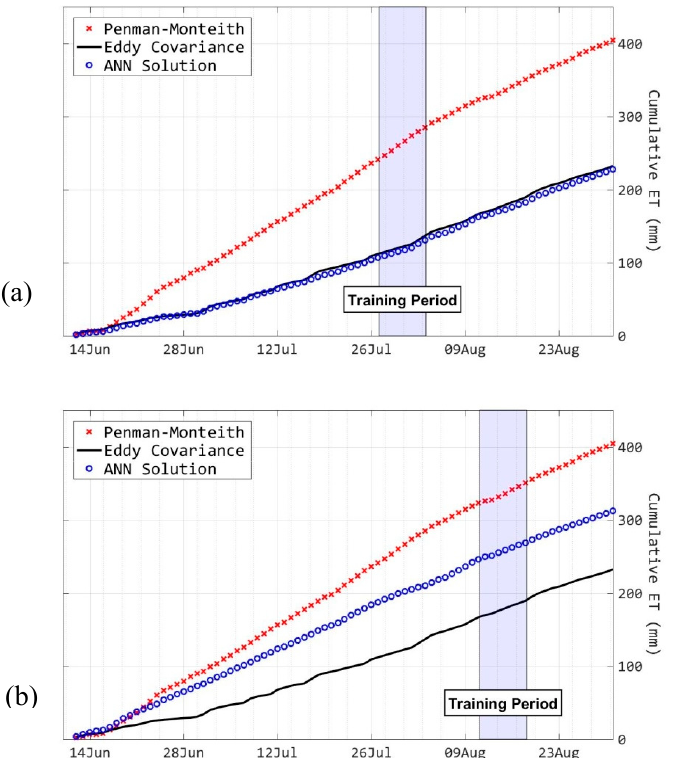
Figure 6. Training results at site 1 using 7-day training periods—Trained during ( a ) midseason and ( b ) end of season. Although half hour comparisons for the two trainings do not appear significantly